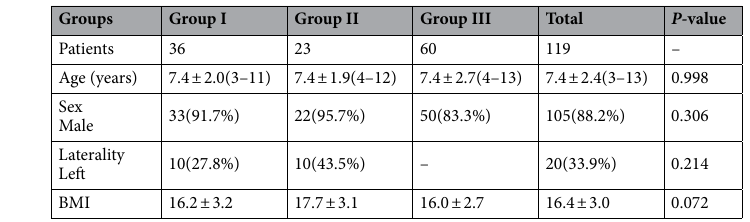
Table 1. Basic information.